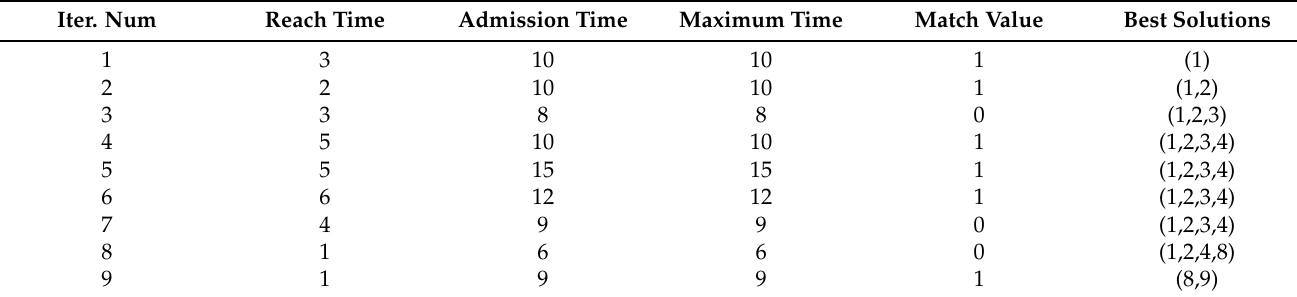
Table 4. A tracing example of admitting the patient considering the nine hospitals.